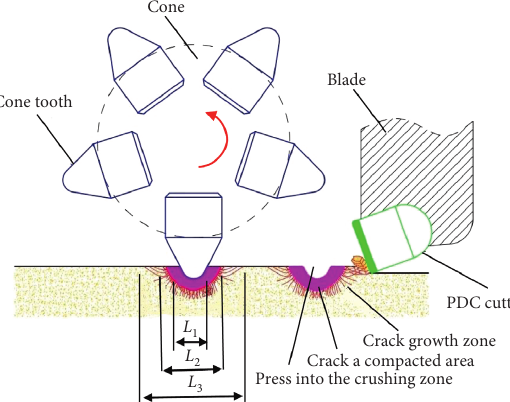
Figure 1: Schematic diagram of the PDC-cone composite bit structure and rock-breaking